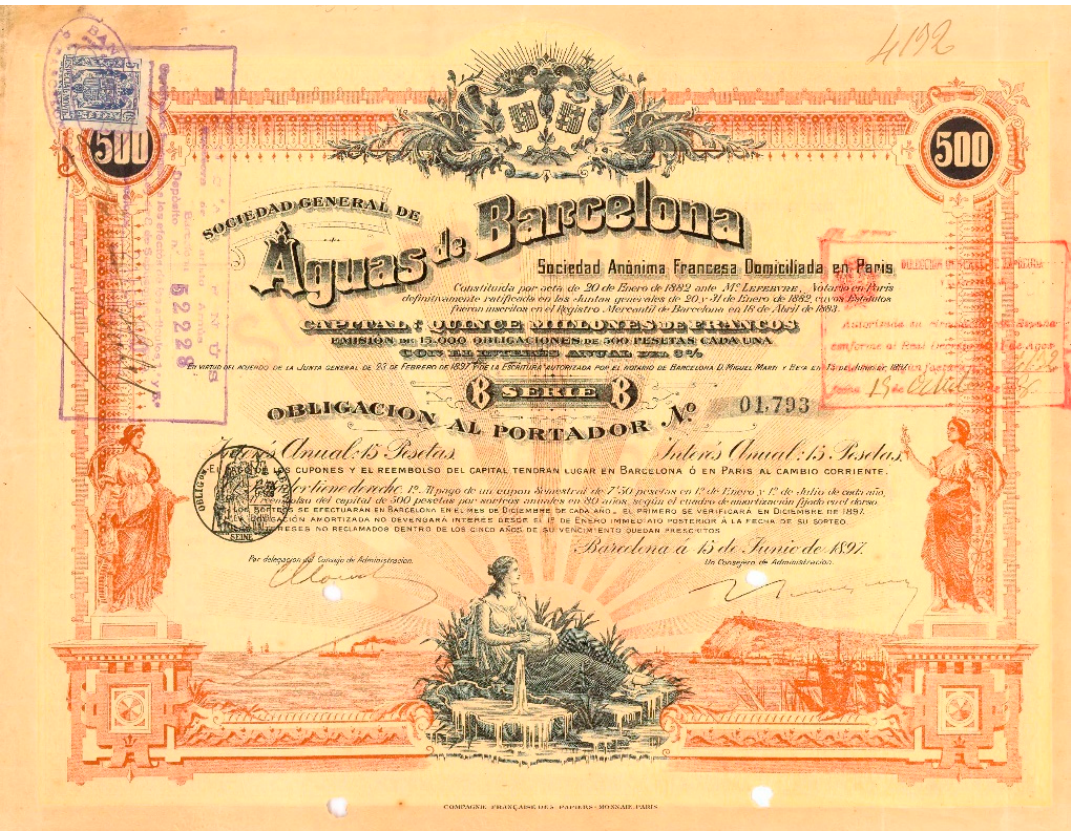
Figure 10. Share of Sociedad General de Aguas de Barcelona (1897).